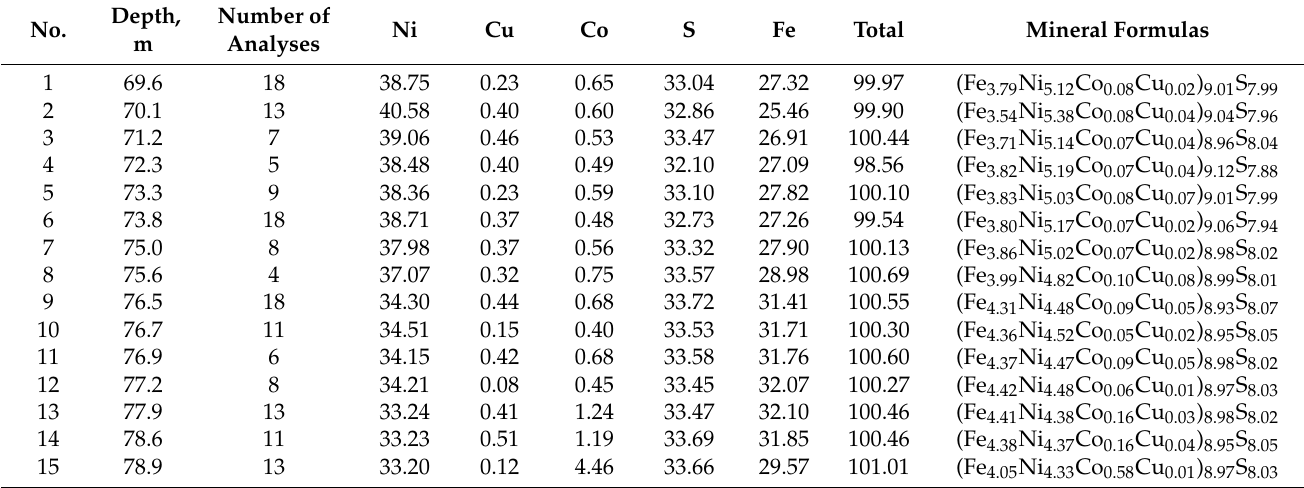
Table 2. Average compositions of the ore-forming pentlandite from Southern-2 ore body of the Talnakh intrusion (borehole EM-7). Depth, No.